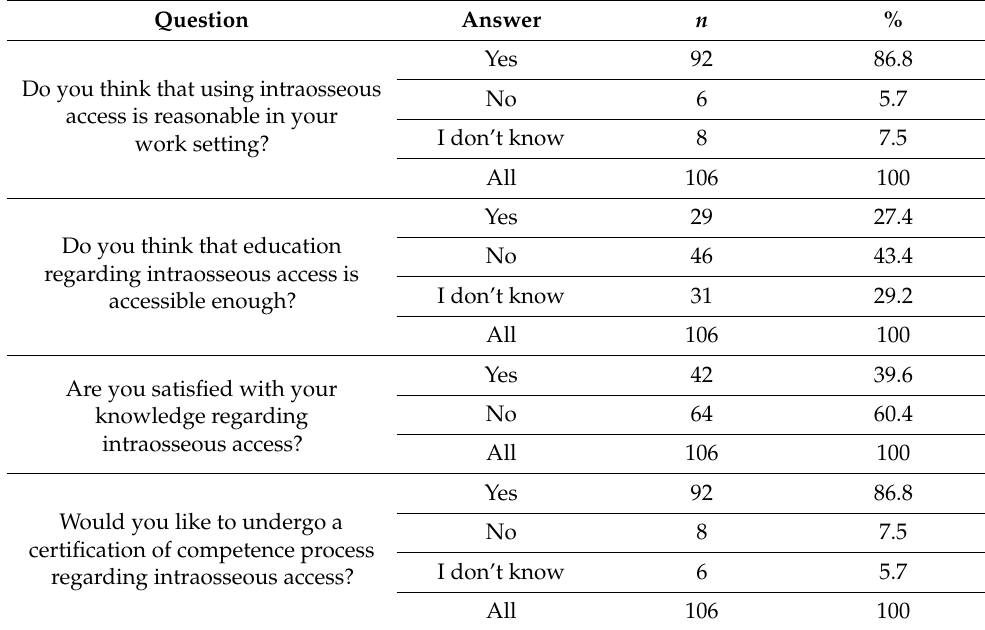
Table 6. Questions regarding education in intraosseous training.